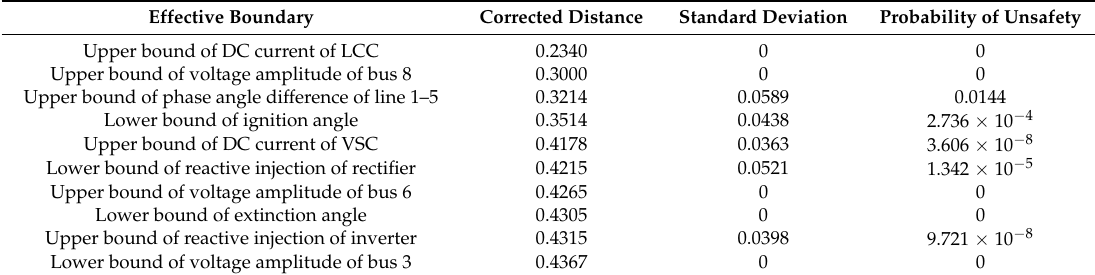
Table 4. Calculation results of the boundaries which have the lowest corrected distances.